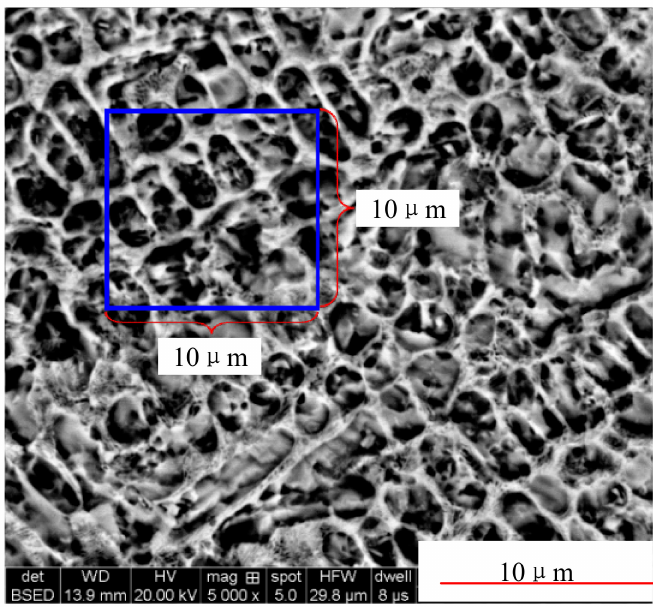
Figure 13. The loss of mass after the wear experiment.